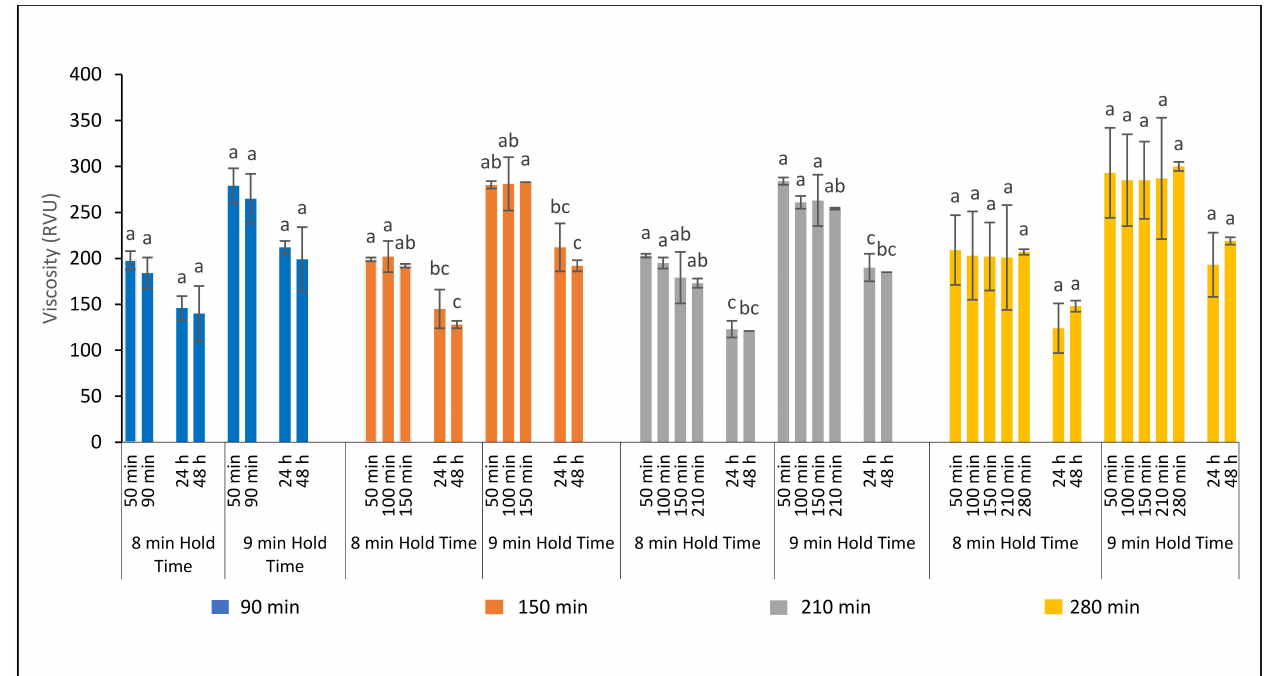
Figure 7. Impact of fermentation time on ferment viscosity measured at 8 and 9 min holding time of the pasting profile during fermentation and ferment storage at 24 h and 48 h. Bars represent the means and standard deviations of two replications. Bars with different letters indicate significant differences for the results for each fermentation time at p < 0.05 (Tukey–Kramer